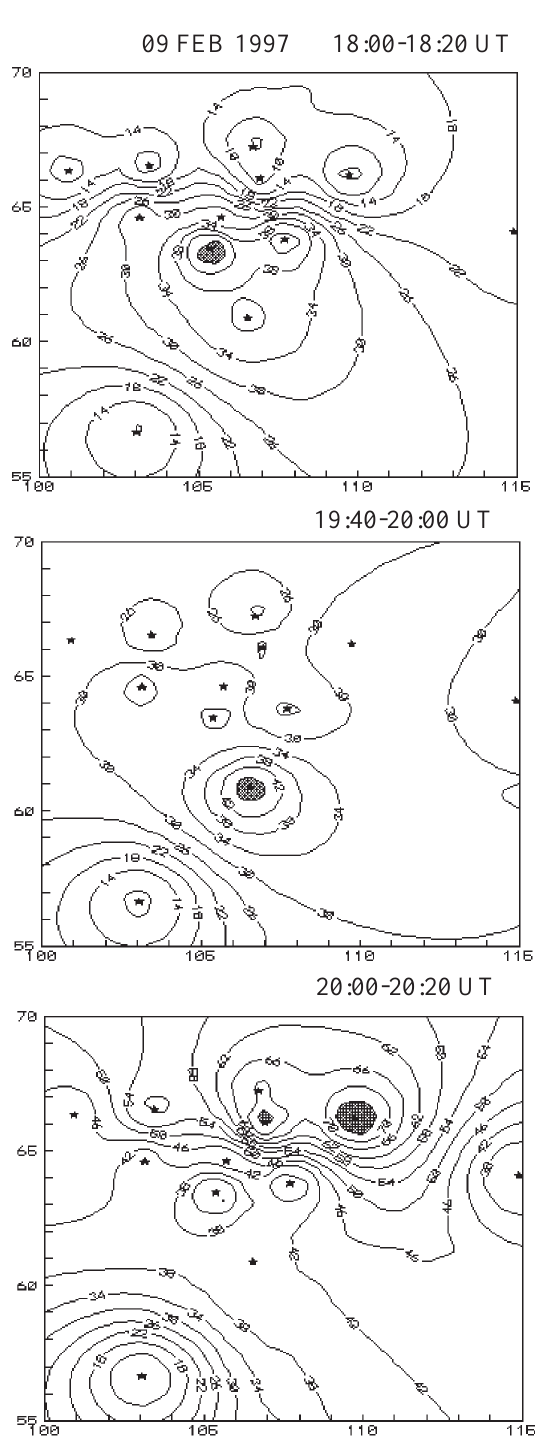
Fig. 5. The spatial distribution of the 0.6–2.0MHz magnetic pulsations in CGM coordinates; asterisks show the station locations.